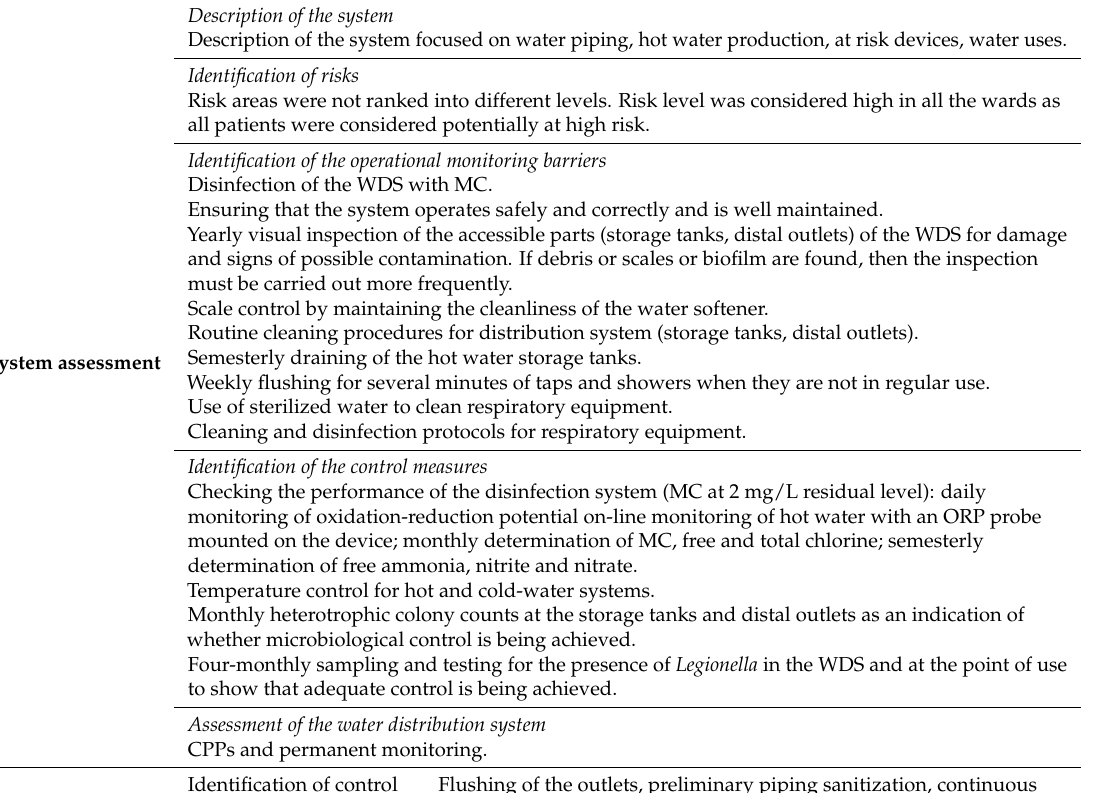
Table 1. The four steps of the Water Safety Plan (WSP) for the control of Legionella implemented at the Hospital ‘Santa Marta e Santa